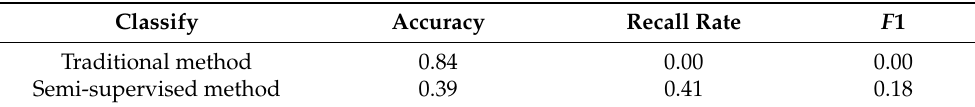
Table 1. Comparison between the traditional method and the semi-supervised